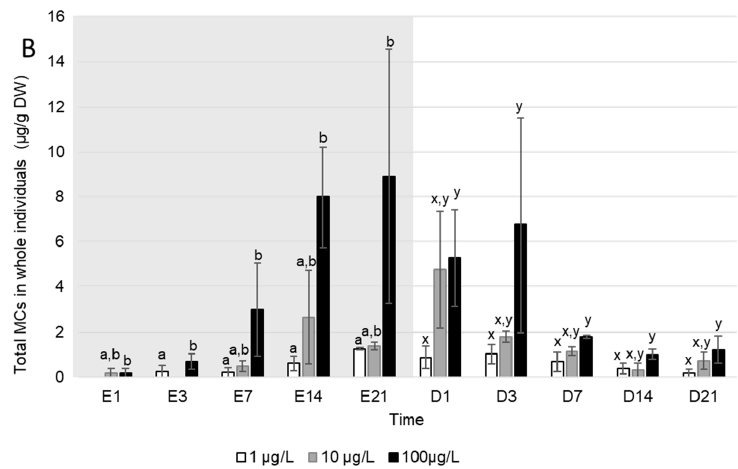
Figure 3. Mean ± S.E.M concentrations (µg/g DW) of ( A ) free and ( B ) total MC accumulated in whole D. polymorpha exposed P. agardhii producing an equivalent of 1 (white), 10 (grey) and 100 (black) µg MC/L, during the exposure (days with the letter E, grey background) and the depuration (days with the letter D, white background), n = 3 pools of 6 individuals. * Indicates a significant difference between concentrations at the same time (Kruskal–Wallis test, p < 0.05). Letters indicate difference in MC accumulation (Kruskal–Wallis, p < 0.05) between exposure concentration series during the exposure (a and b), and the depuration (x and y).